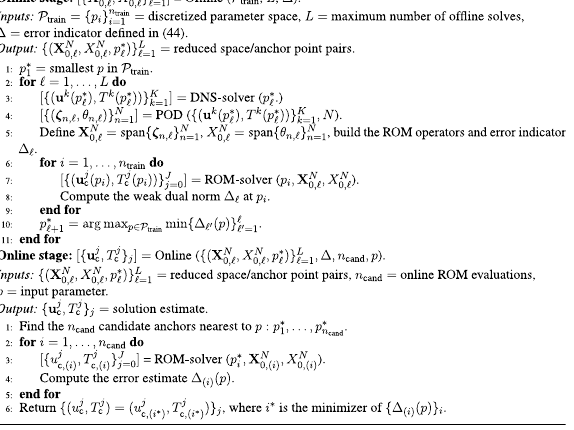
Algorithm 1. POD- h Greedy algorithm for the construction